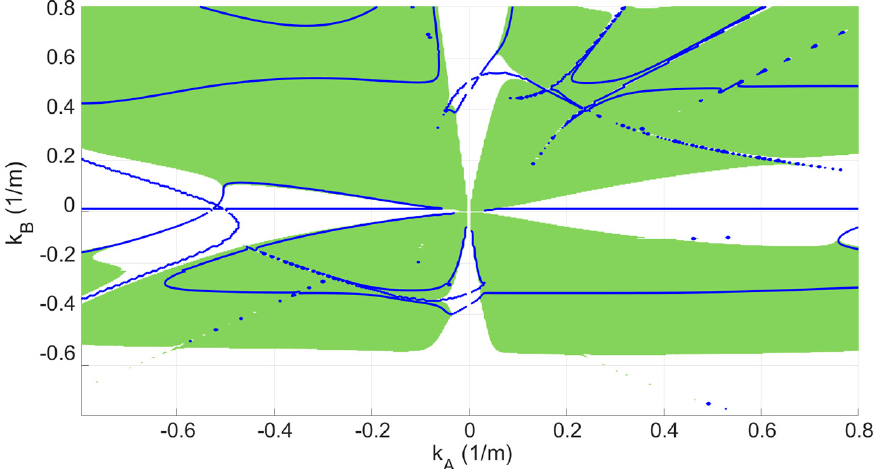
Figure 6. The region where −2 ≤ 𝐹 (cid:2870) ≤ 2 when 𝑈 (cid:3040) = −0.5 ( m/s ) . The blue lines indicate where 𝐹 (cid:2870) = 0 .